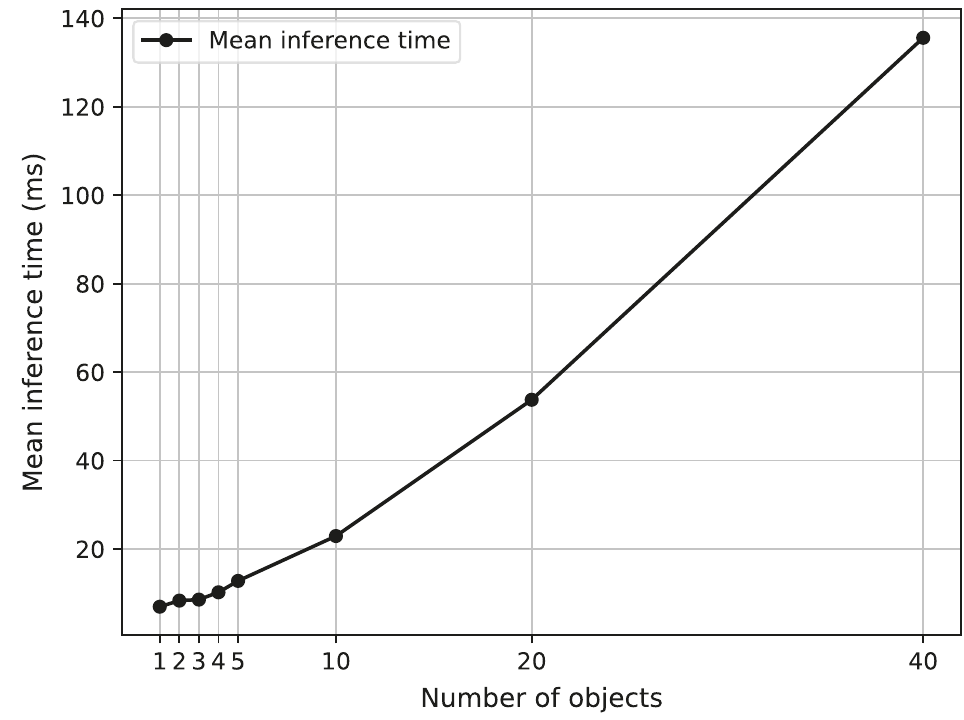
Figure 24. Mean inference time for MOT stage over number of objects.